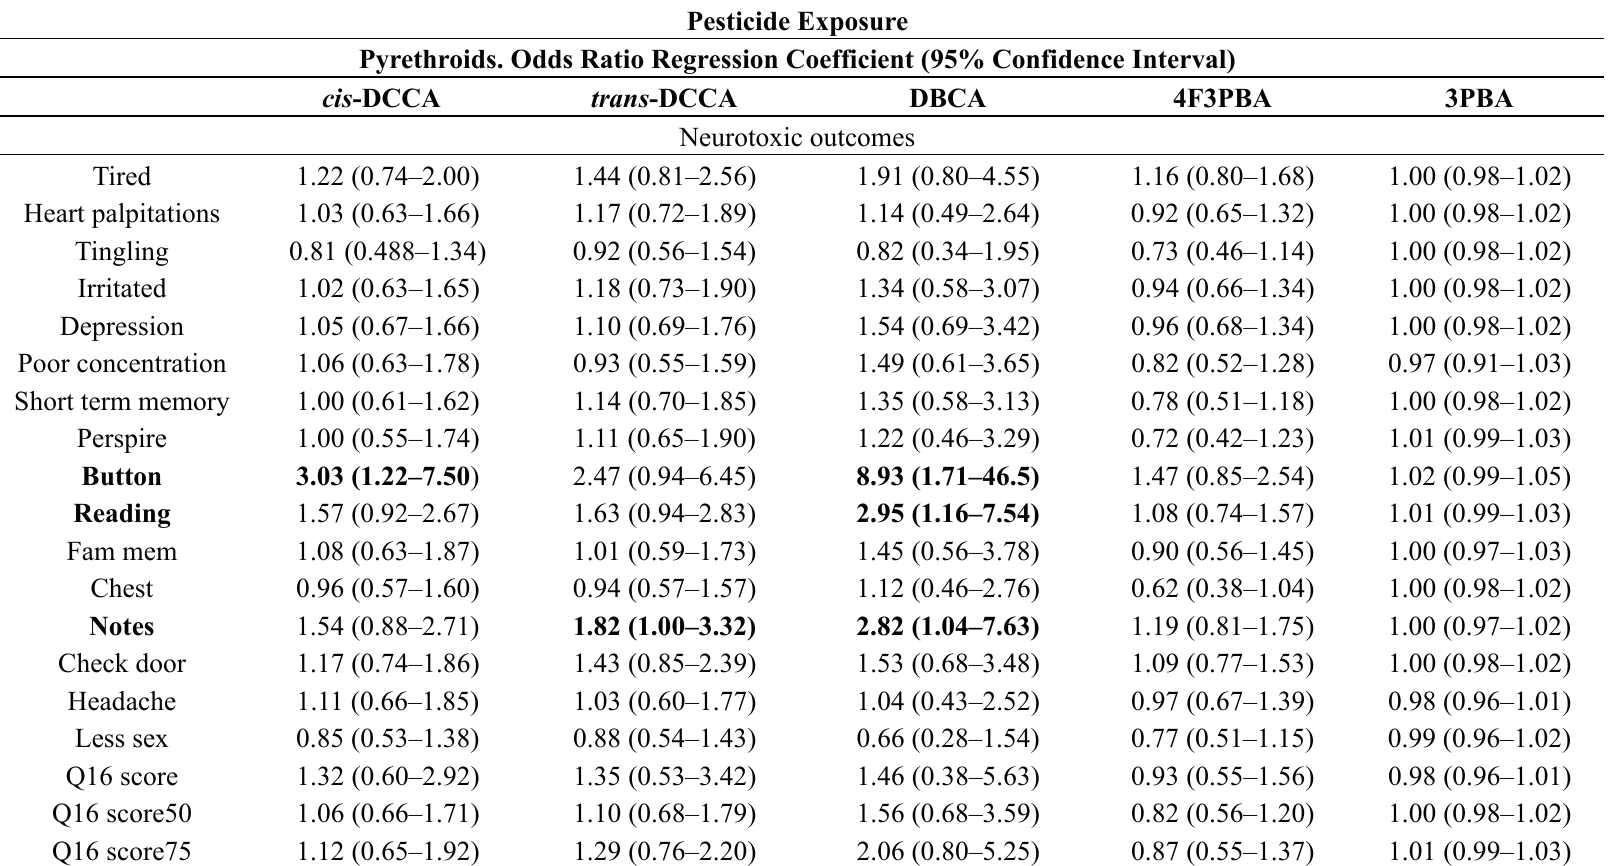
Table 7. Adjusted models for the association between pyrethroid metabolites and Q16 outcomes among rural women in Western